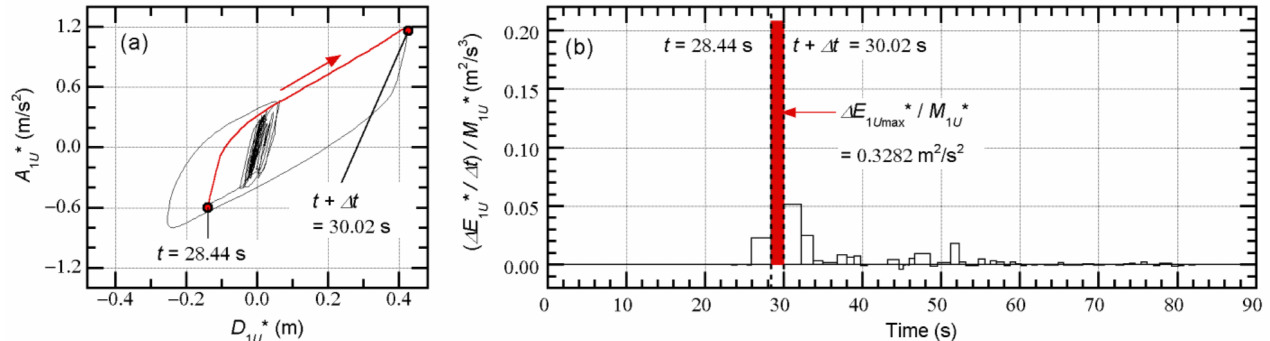
Figure 32. Definition of the maximum momentary input energy of the first modal response per unit mass (structural model: Model-Tf44, ground motion: TCU, angle of incidence of seismic input: ψ = − 30 ◦ ): ( a ) Hysteresis of the first modal response and ( b ) time-history of the momentary energy input.